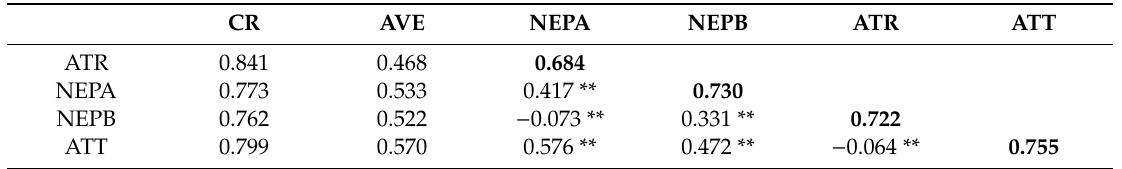
Table 5. Measurement model measures of reliability and discriminant validity. CR AVE NEPA NEPB ATR ATT